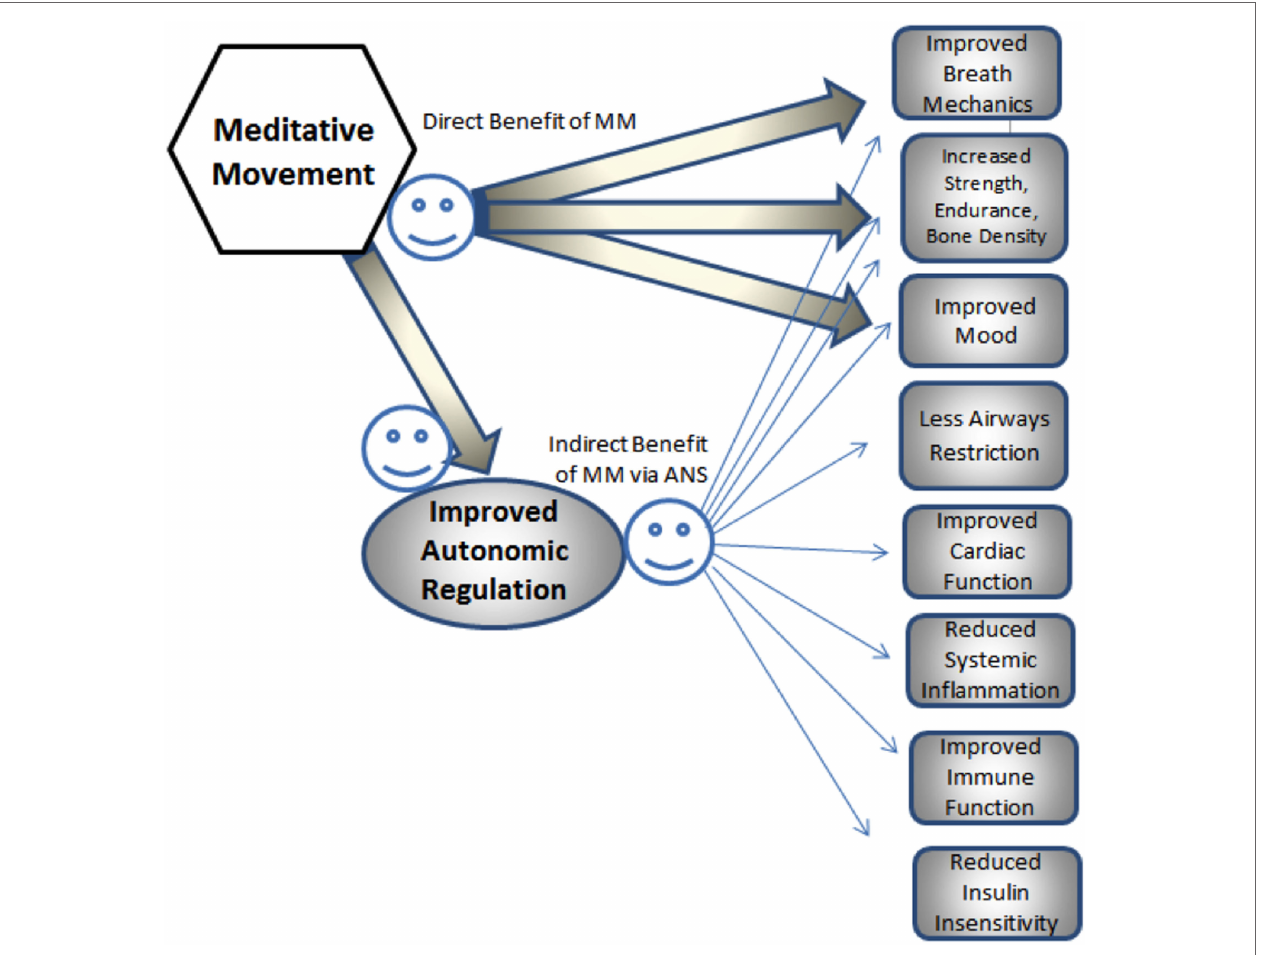
FIGUrE 3 | Hypothesized pathways of direct and indirect influence of MM on co-morbidities of coPD